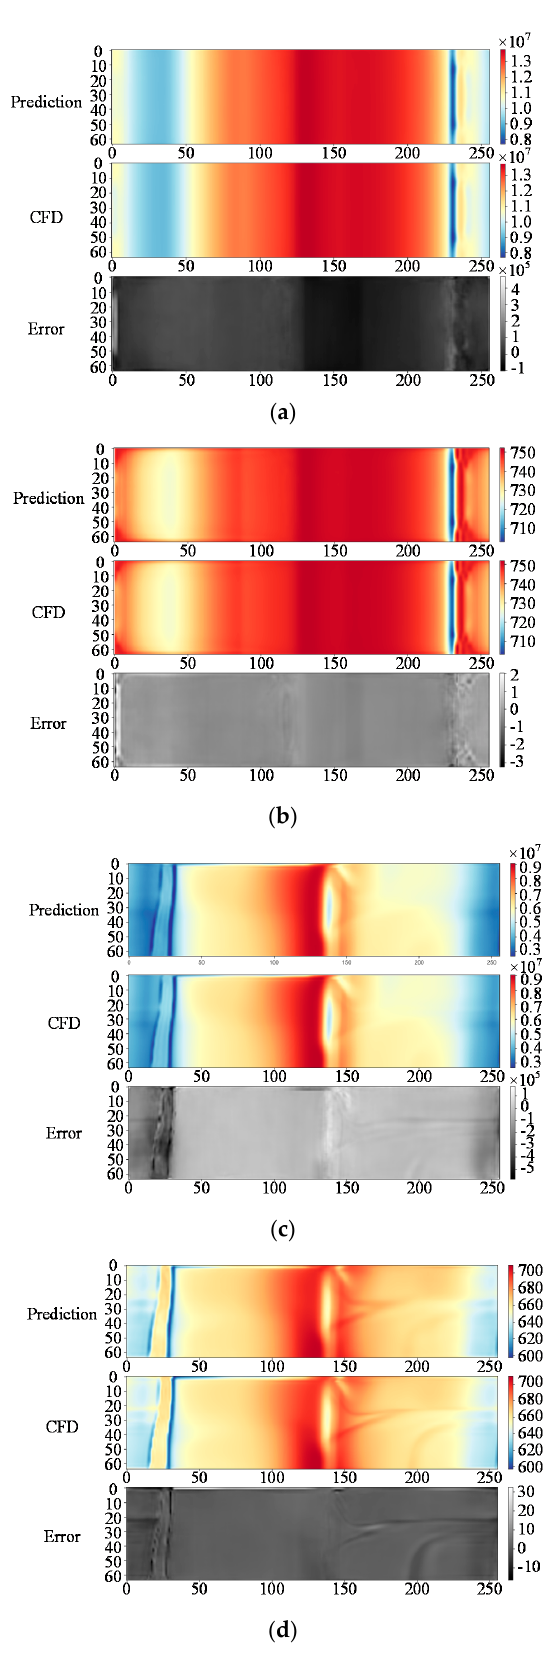
Figure 12. The parameter distribution of Case B: ( a ) the pressure of the stator blade; ( b ) the temperature of the stator blade; ( c ) the pressure of the rotor blade; ( d ) the temperature of the rotor